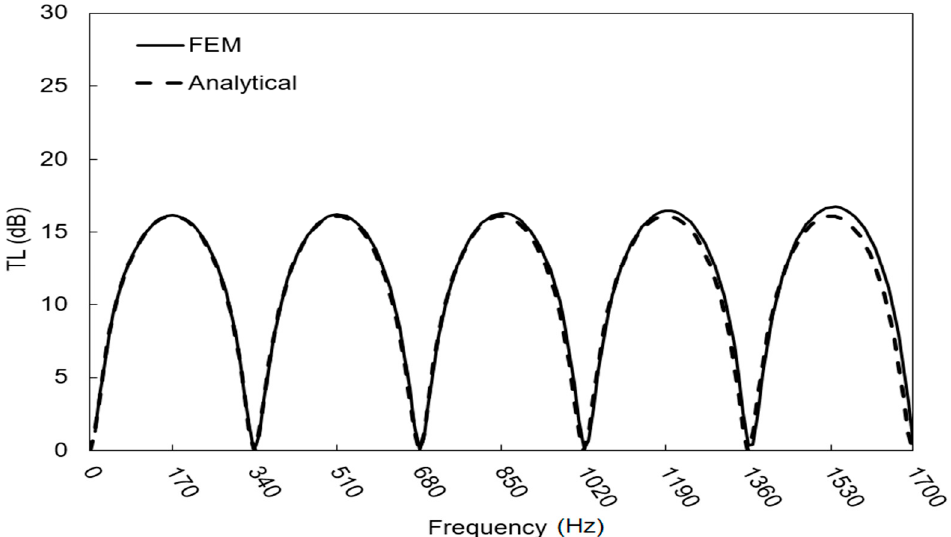
Figure 11. Comparison between analytical and FEM-simulated TL of the simple expansion chamber without discontinuity.